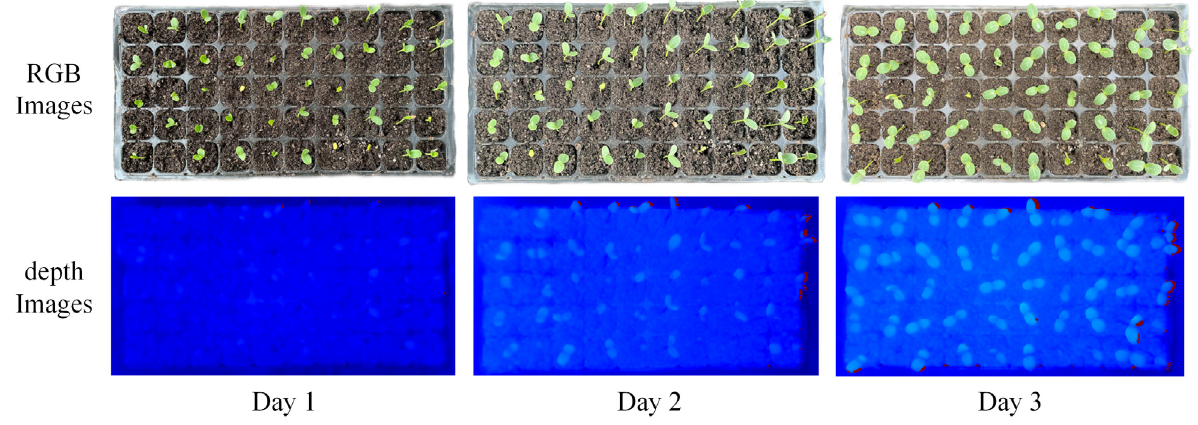
Figure 2. Continuous acquisition of color images with depth images.